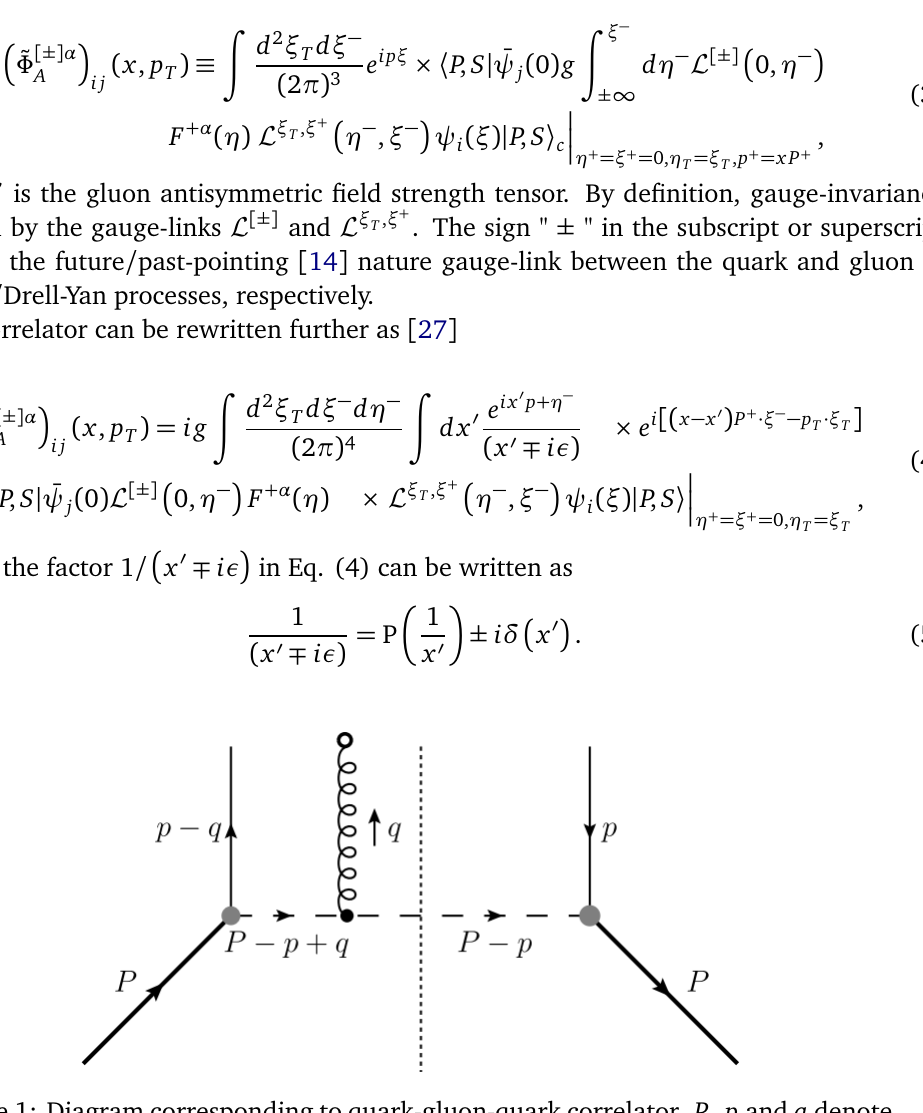
Figure 1: Diagram corresponding to quark-gluon-quark correlator. P , p and q denote the nucleon, quark and diquark momenta respectively [ 27,28 ]